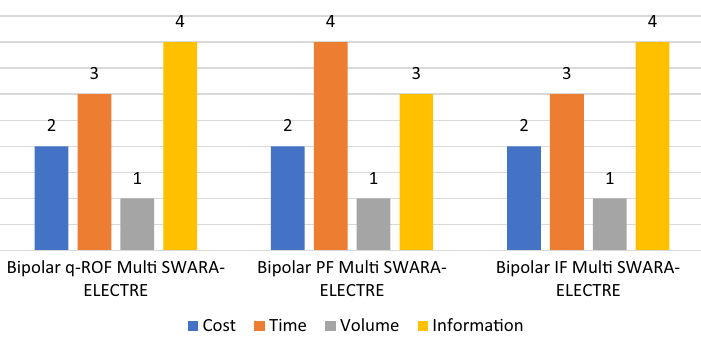
Fig. 5 Graphical representations of the ranking